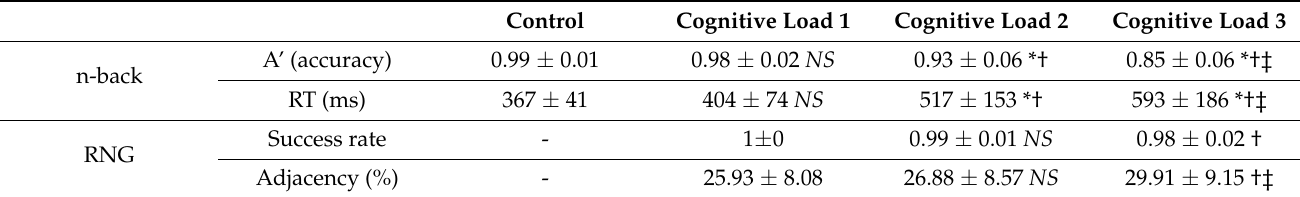
Table 1. Effect of cognitive load on behavioral